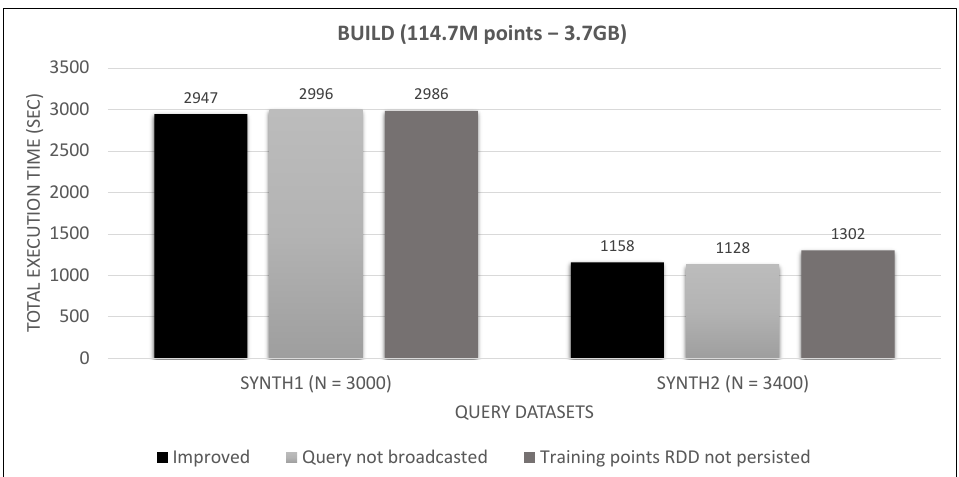
Figure 31. Small training dataset broadcast and persist tests.